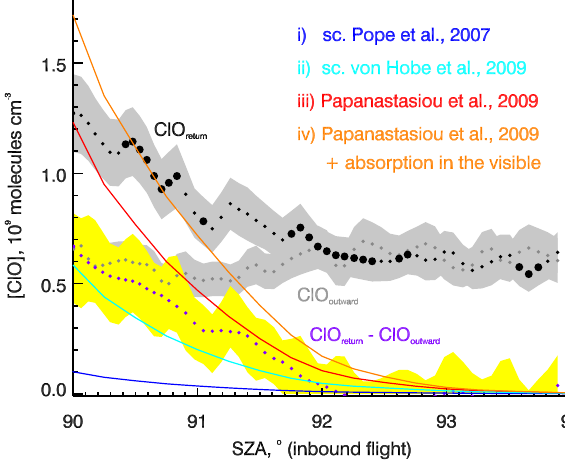
Fig. 8. Comparison of the observed rise of ClO concentrations (marked by the purple symbols) with SZA to the integrated ClO produced by simulations using photolysis rates J ClOOCl based on i–iv (solid lines, cf. Sect. 2.4). The measured rise is calculated by subtraction of ClO measured on the outbound flight leg (grey sym- bols) from ClO measured on the inbound flight leg (shown as black symbols with the thicker ones representing strict match pairs). The outbound ClO data are plotted according to the SZA at the matching inbound measurements. Grey and yellow areas show the measure- ment